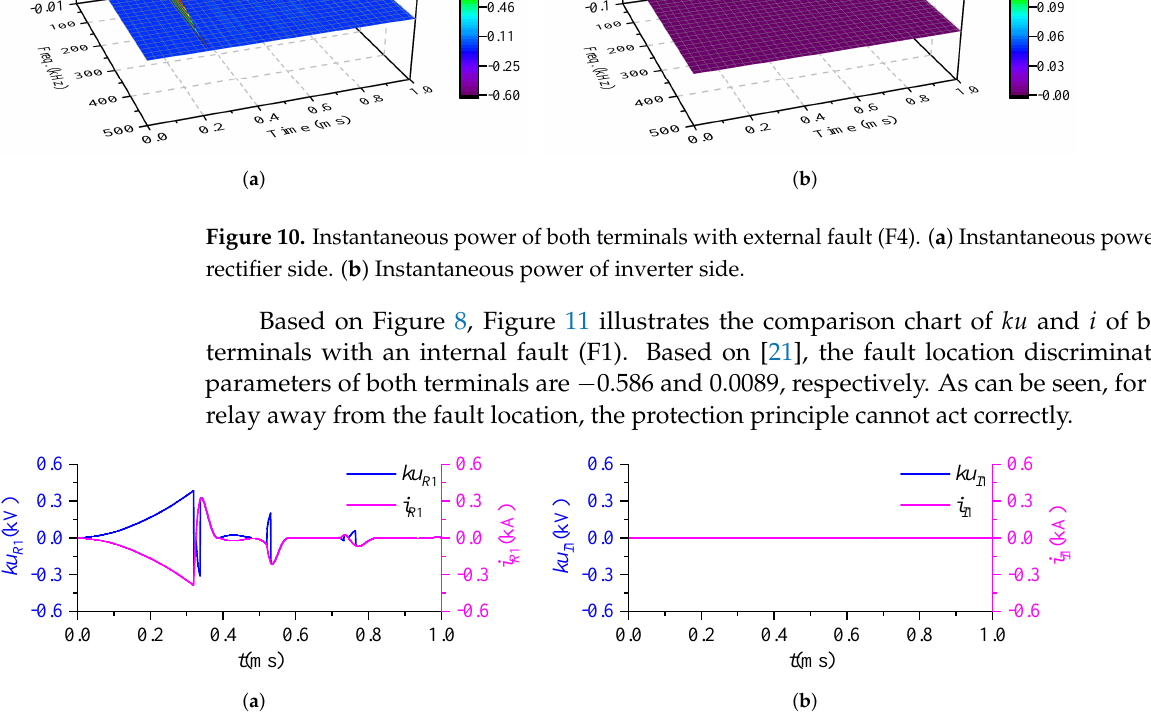
Figure 11. Comparison chart of ku and i of both terminals with internal fault (F1). ( a ) Rectifier side. ( b ) Inverter side.